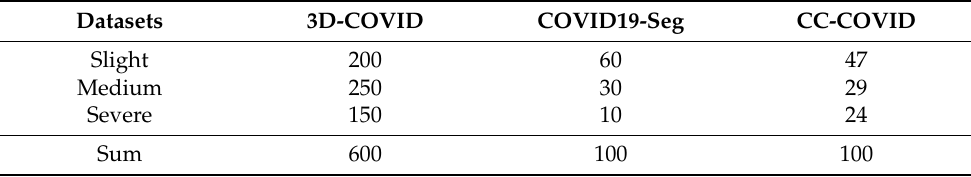
Table 2. Annotate the number of samples of different severity in the